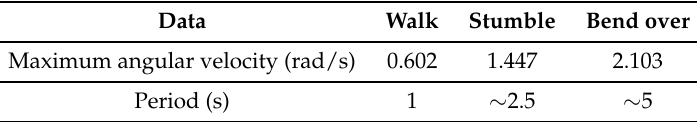
Table 2. Summary of Figure 2 (module